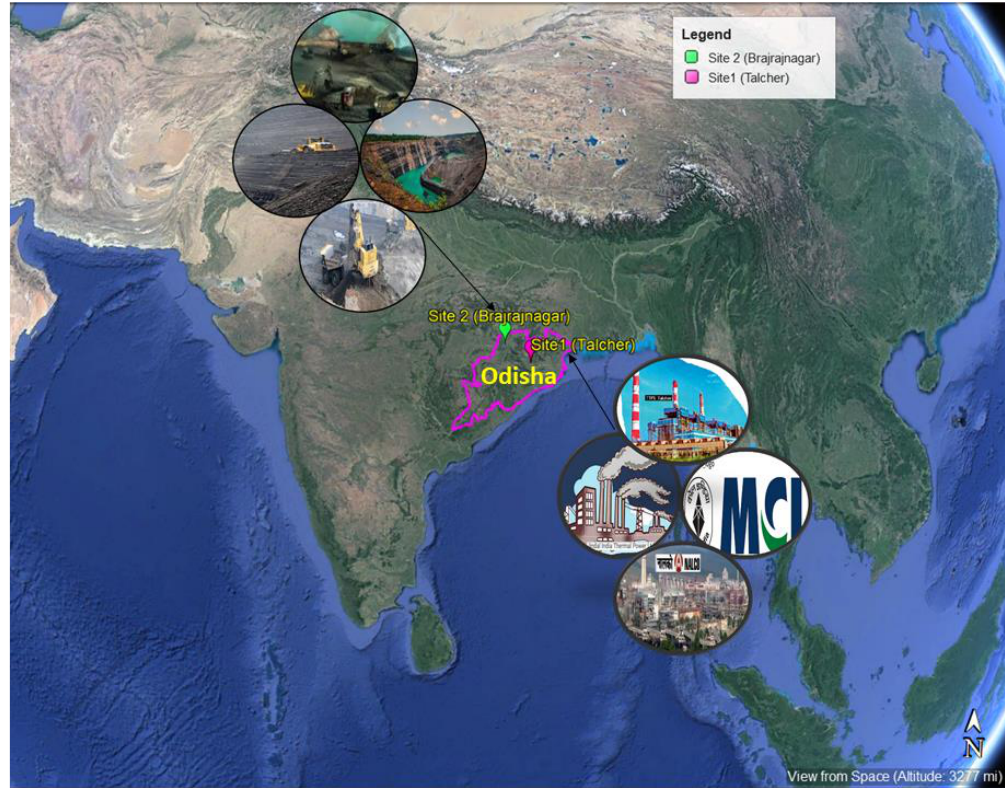
Figure 1. Map of study area map.